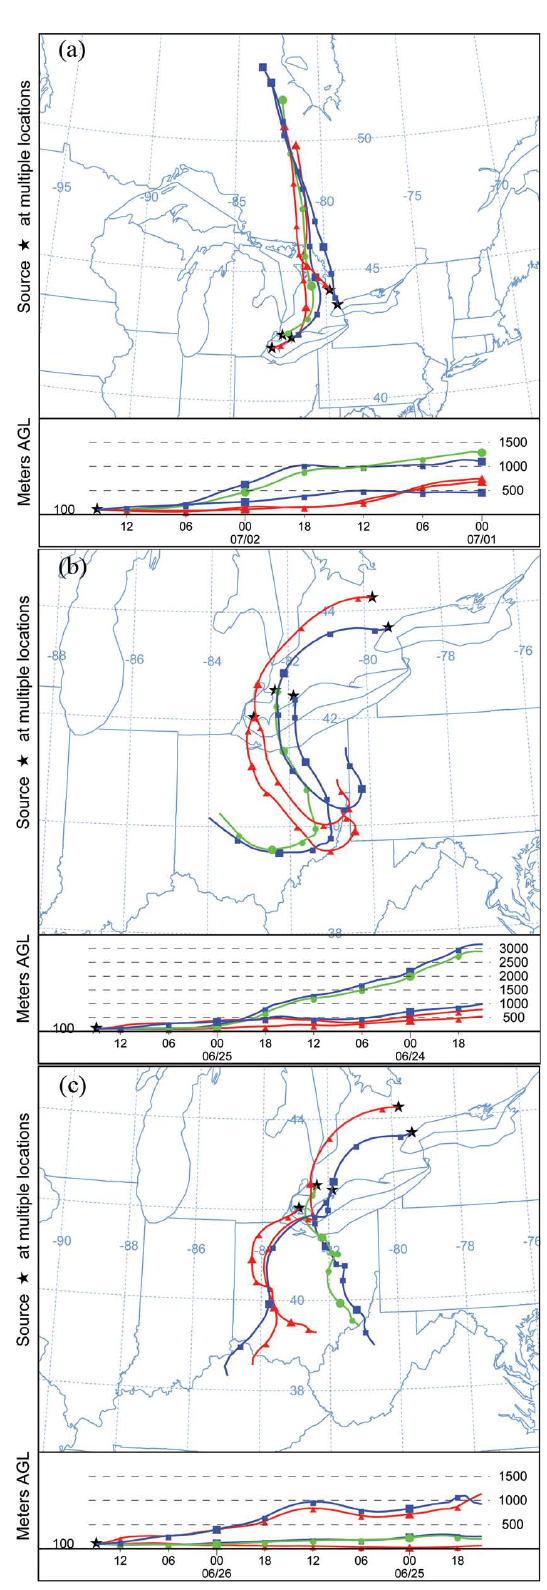
Fig. 8. 48-h back trajectories at the five monitoring sites on 2 July – Class I, (a) , 25 June – Class II, (b) , and 26 June – non-event, (c)